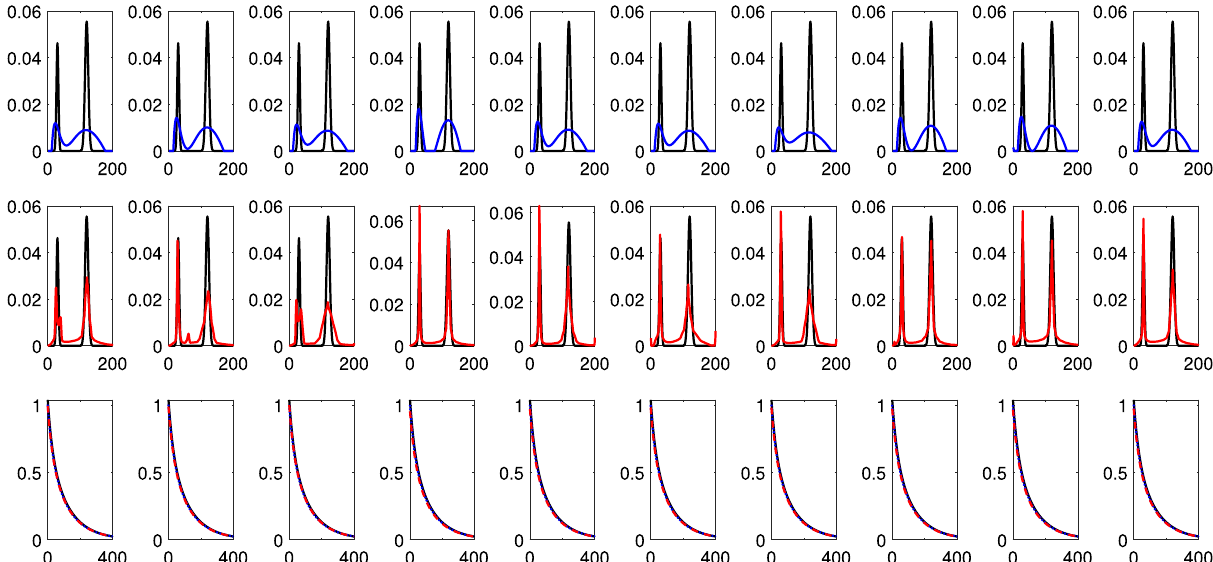
Figure 3. Reconstruction of the sum of two Gaussians with (µ 1 , σ 1 ) = (30 ms, 3 ms) and (µ 2 , σ 2 ) = (120 ms, 5 ms), shown in black in the top and middle rows; SNR = 500. Each column corresponds to a single noise realization. Top: DP (blue), Middle: SpanReg (red), Bottom: signals generated from the DP solution and the SpanReg solution.